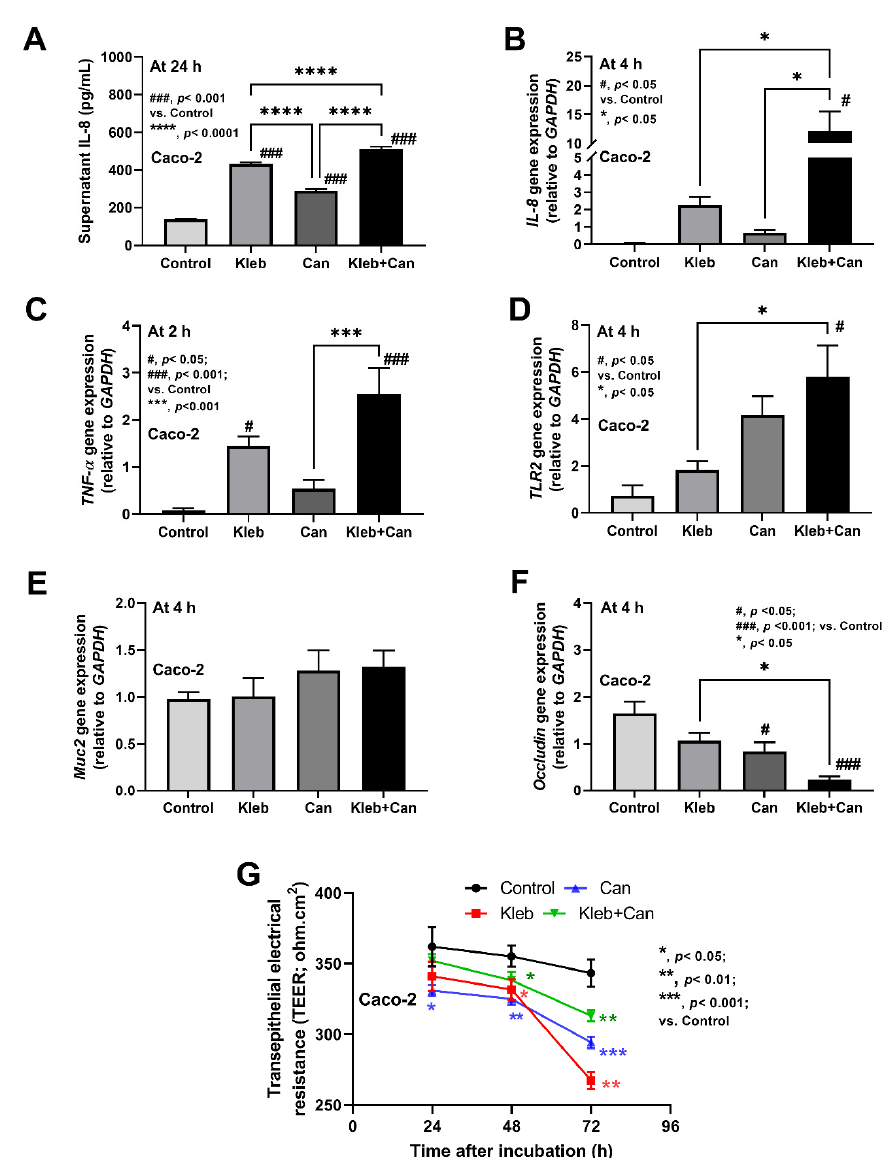
Figure 6. The characteristics of enterocytes (Caco-2 cells) after the activation by media control (control) and the preparations from K. pneumoniae (Kleb) or C. albicans (Can) alone or the combination (Kleb+Can) as indicated by supernatant IL-8 at 24 h post-incubation ( A ) or the gene expression (4 h post-incubation) of inflammatory molecules ( IL-8 , TNF- α , and toll-like receptor-2 ( TLR-2 )), mucin ( Muc2 ), and tight junction ( Occludin ) ( B – F ) with the transepithelial electrical resistance (TEER) ( G ).(Independent triplicated experiments were performed.) #, p < 0.05; ###, p < 0.001 vs. control; *, p < 0.05; **, p < 0.01; ***, p < 0.001; ****, p < 0.0001, the indicated groups as have determined by ANOVA with Tukey’s analysis.